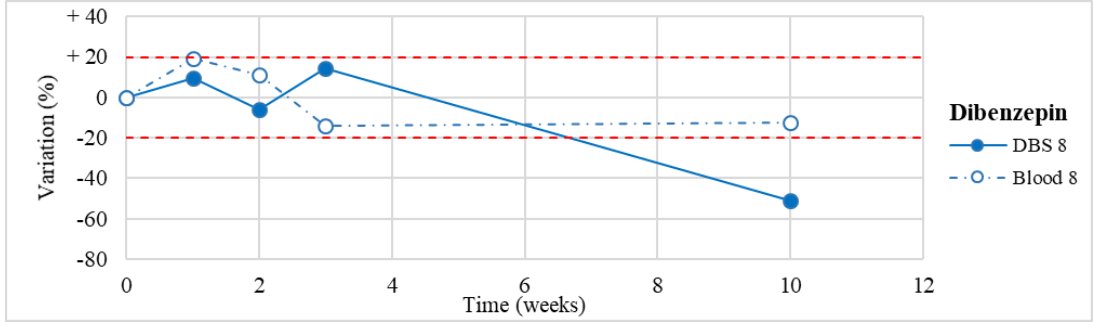
Figure 8. Long-term stability of trazodone ( n = 2) in DBSs stored at room temperature and in blood stored at −20 °C (blood of case n°10 was tested also at T1, T2, T3).